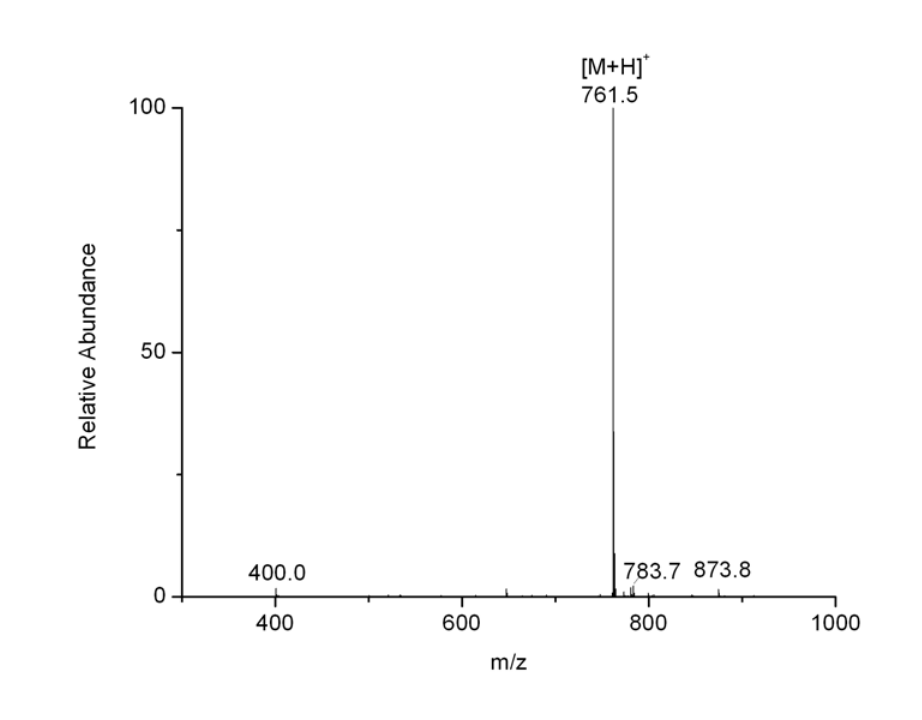
Fig. 4 ESI full scan spectrum of crude heptapeptide 1 .